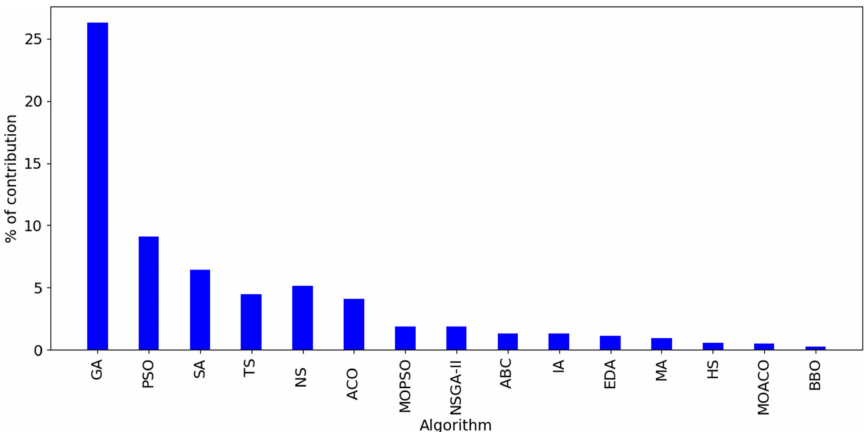
Figure 4. Contribution of different metaheuristic algorithms applied to scheduling